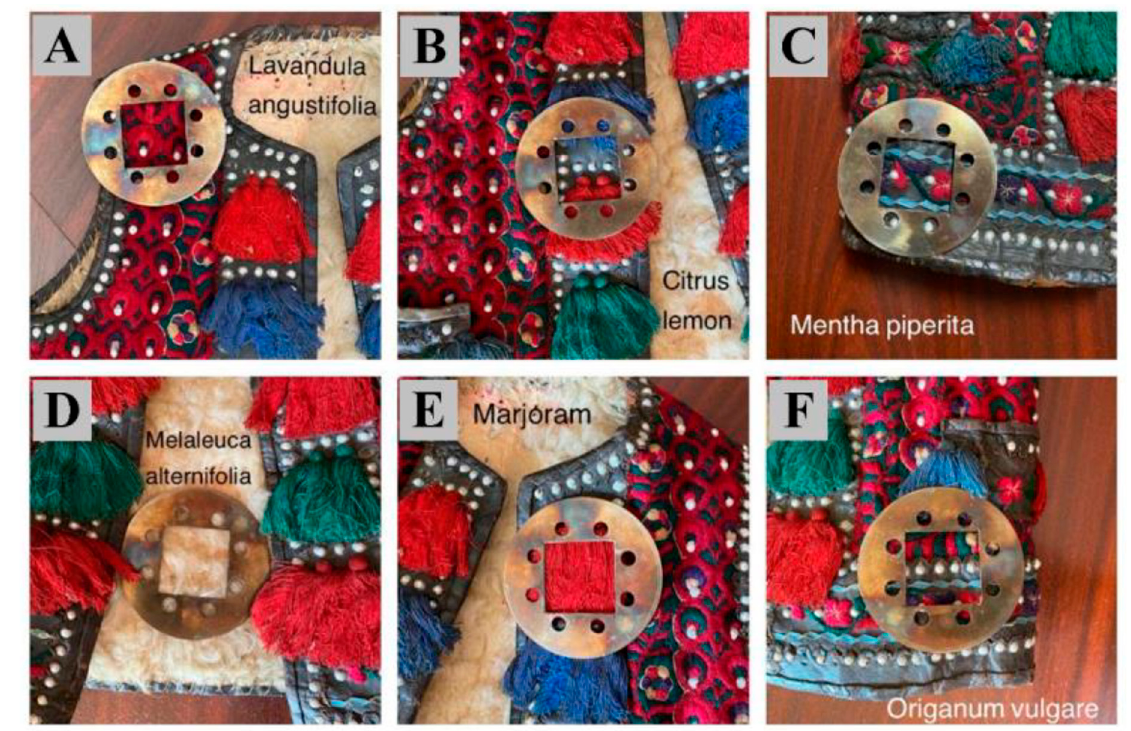
Figure 2. Delimitation of the six work areas on the front of the coat, indicating the type of essential oil applied to each ( A )— Lavandula angustifolia ; ( B )— Cistrus lemon ; ( C )— Mentha piperita ; ( D )— Melaleuca alternifolia ; ( E )— Marjoram ; ( F )— Origanum vulgare . Table 1. Areas of the sheepskin coat examined, and to which essential oils applied. Examined Area (Figure